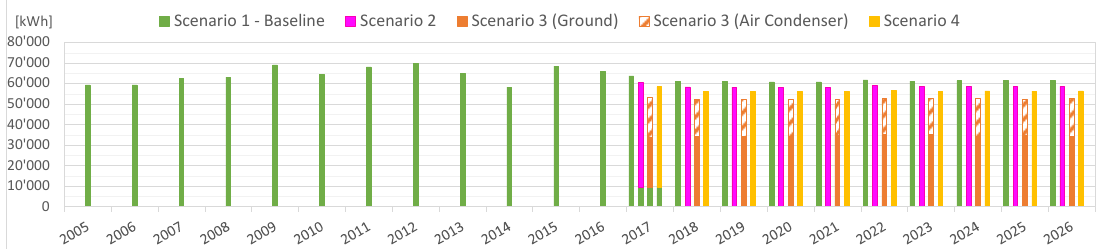
Figure 10. Annual electrical consumption of the heat pump for each simulated scenario.